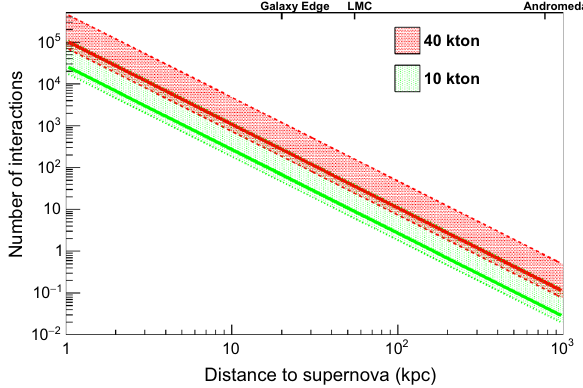
Fig. 12 Estimated numbers of supernova neutrino interactions in DUNE as a function of distance to the supernova, for different detector masses ( ν e events dominate). The red dashed lines represent expected events for a 40-kton detector and the green dotted lines represent expectedeventsfora10-ktondetector.Thelineslimitafairlywiderange ofpossibilitiesforpinched-thermal-parameterizedsupernova fluxspec- tra (Eq. 2.2) with luminosity 0 . 5 × 10 52 ergs over 10 s. The optimistic upper line of a pair gives the number of events for average ν e energy of (cid:5) E ν (cid:6) = 12 MeV, and pinching parameter α = 2; the pessimistic lower e (cid:6) = 8 MeV and α = 6. line of a pair gives the number of events for (cid:5) E ν e (Note that the luminosity, average energy and pinching parameters will vary over the time frame of the burst, and these estimates assume a con- stant spectrum in time. Flavor transitions will also affect the spectra and event rates.) The solid lines represent the integrated number of events for the specific time-dependent neutrino flux model in [8] (see Figs. 1 and 2; this model has relatively cool spectra and low event rates). Core collapses are expected to occur a few times per century, at a most-likely distance of around 10–15